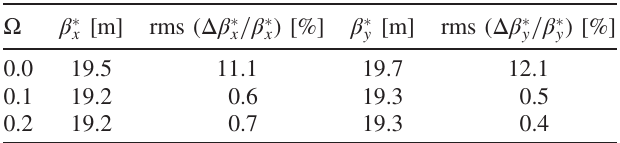
TABLE II. Reconstructed average and uncertainty of β (cid:1) and waist from K modulation for β (cid:1) ¼ 19 m optics configuration.